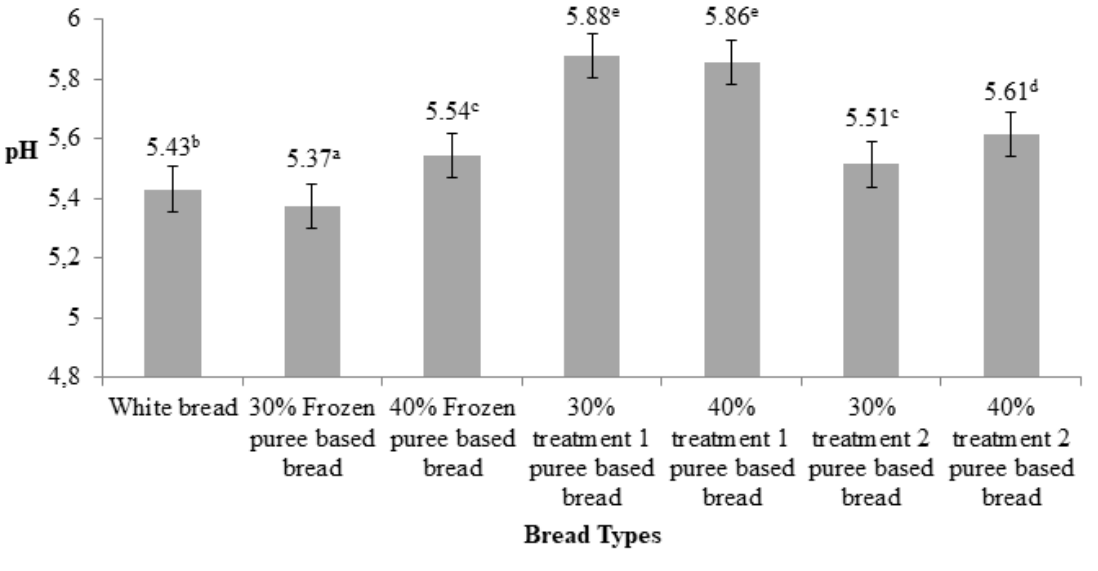
Figure 2: pH of dough used in bread baking (Means with different letters in the superscript are significantly different at P<0.05, LSD